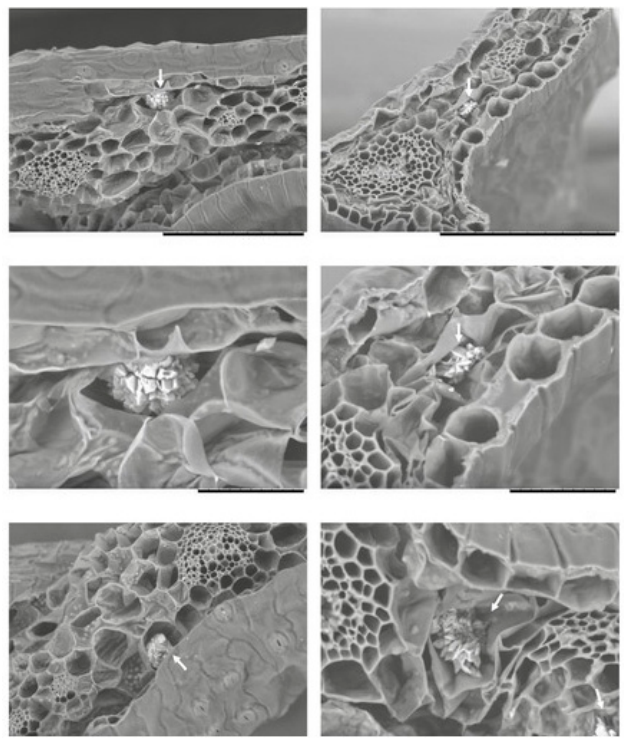
Figure 1. Random sample of electron micrographs of calcium oxalate crystals in different grape leaves in the dataset used; as can be seen, the crystals are of different sizes (white arrows point to the crystals).